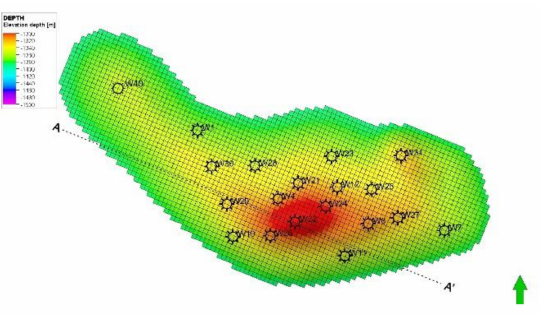
Figure 4. Top view of the reservoir simulation model. Localization of additional well W40.